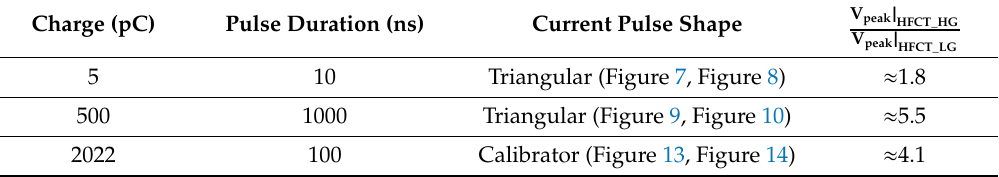
Table 4. Ratio of peak values for the same current pulses using the HFCT_LG and HFCT_HG sensors.